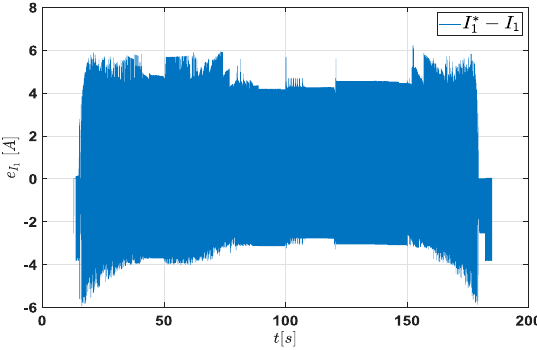
Figure 19. Current error response of phase 1 using SM.